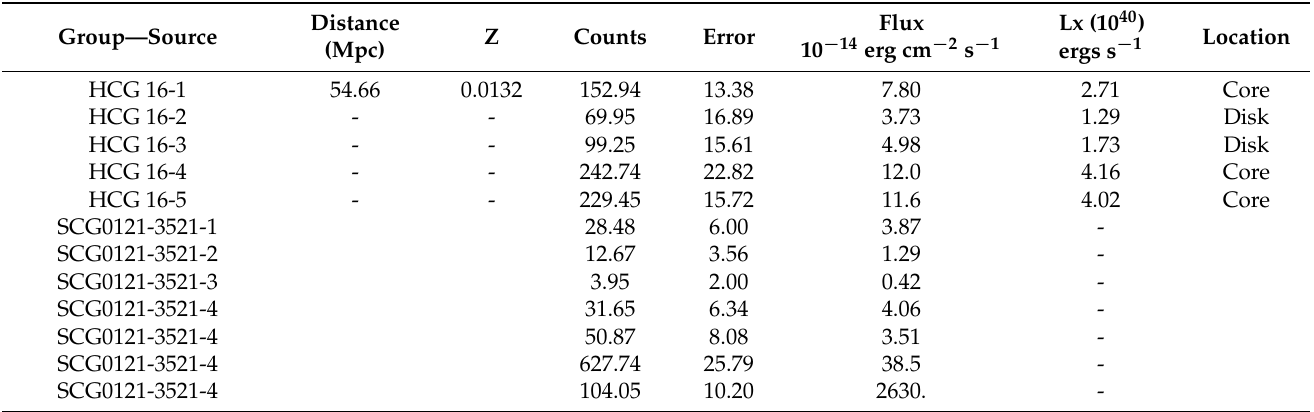
Table 1. Compact Groups with a specific selection